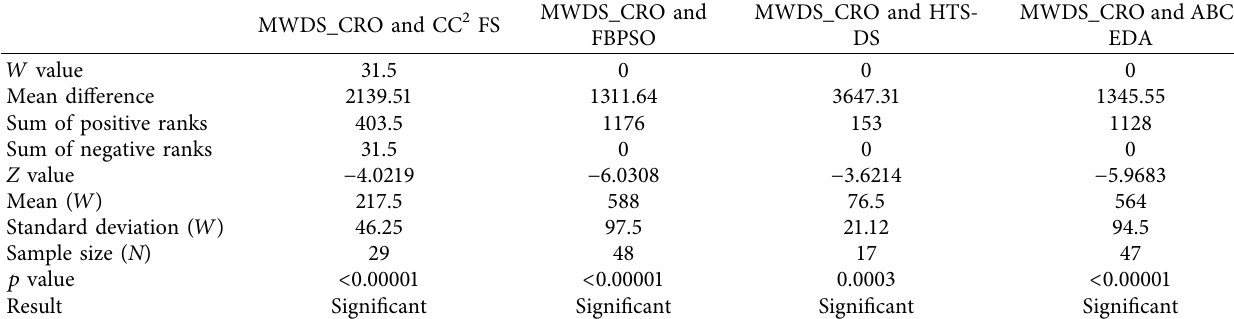
Table 13: Wilcoxon signed-rank test for TI instances.